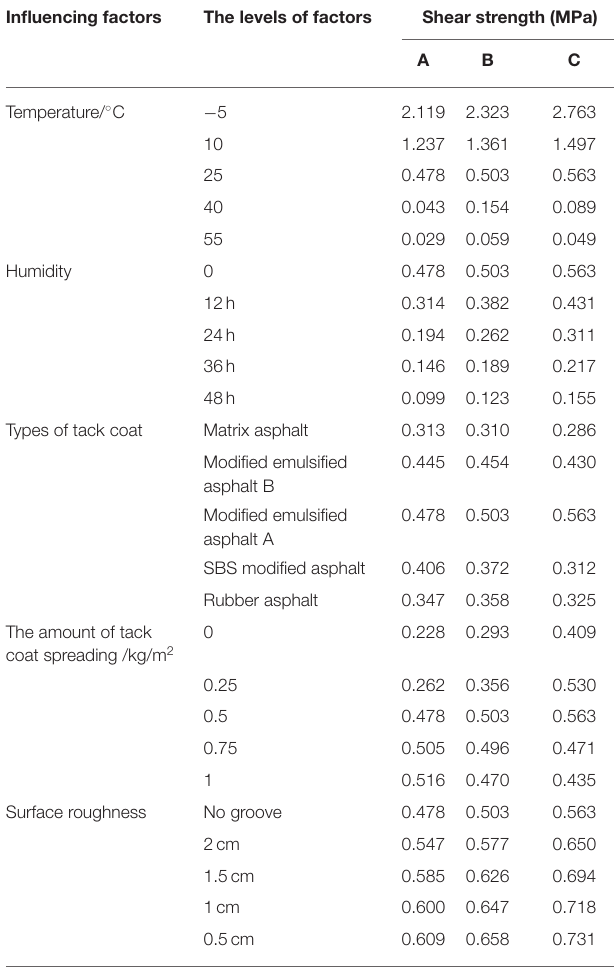
TABLE 1 | Results of the oblique shear test under different influencing factors. Influencing